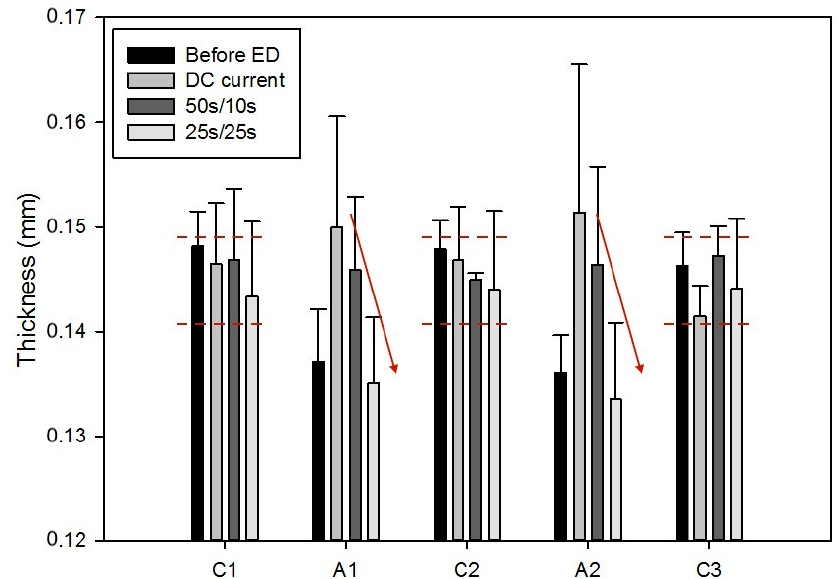
Figure 6. Membrane thickness measurements for all membranes of the ED configuration, before and after treatment, for the three different current conditions. The arrows show the thickness decreasing tendency depending on the applied current condition.